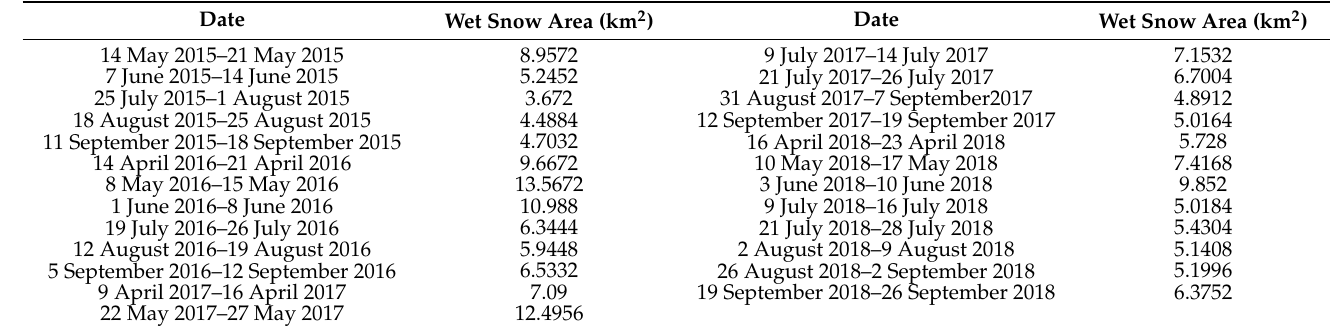
Table 3. Acquisition dates of the SAR ascending and descending images used for the wet snow area detection and the results of the detected wet snow area. The reference image is the average of multiple SAR images of snow-free or dry snow-covered scenes in the fall and winter, which are not listed